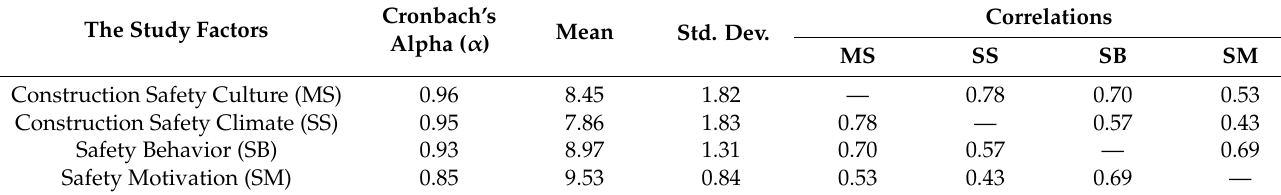
Table 1. Descriptive analysis